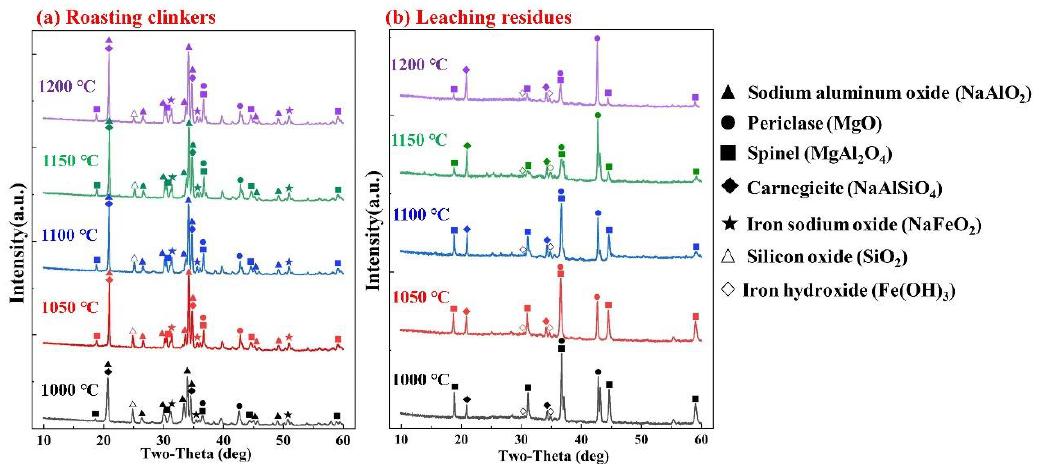
Figure 6. XRD patterns of the roasting clinkers ( a ) and leaching residues ( b ) under different roasting temperatures.